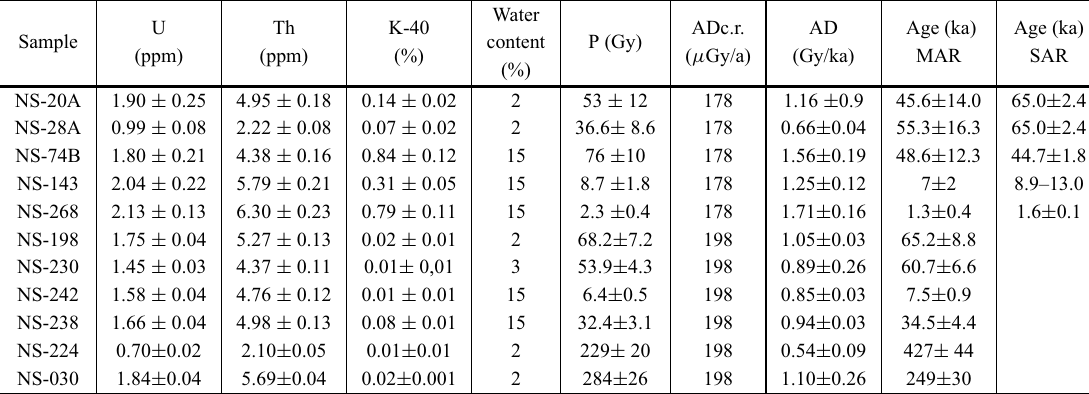
Radioactive isotope concentrations of the samples, water content, paleodose (P) by MAR, cosmic radiation contribution (ADc.r.), total annual dose rate (AD) and ages by MAR and SAR protocols. Water ADc.r. AD Age U Th K-40